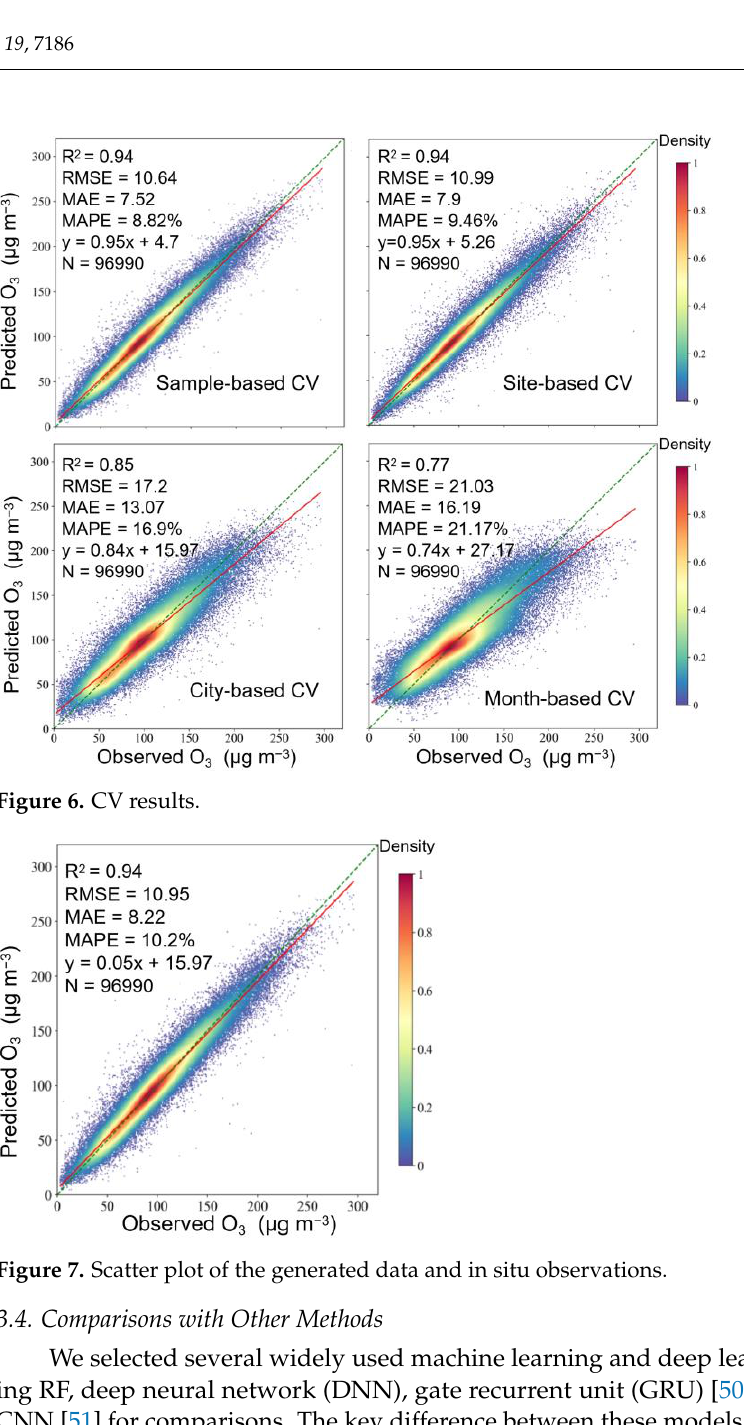
Figure 8. Quarterly averages of MDA8 ozone of TAP, ARLSTM and in situ observations. The line plot below is a comparison of RMSE between the two datasets and in situ observations. 3.4. Comparisons with Other Methods We selected several widely used machine learning and deep learning models including RF, deep neural network (DNN), gate recurrent unit (GRU) [50], original LSTM and CNN [51] for comparisons. The key difference between these models is how the spatiotemporal relationship of variables is processed. RF and DNN have no special